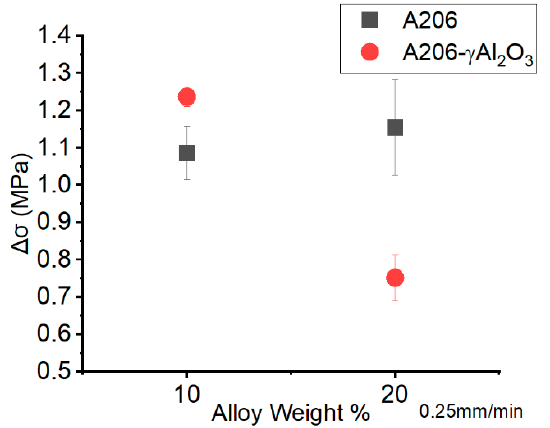
Figure 12. PLC signal amplitude at a 0.250 mm/min strain rate.